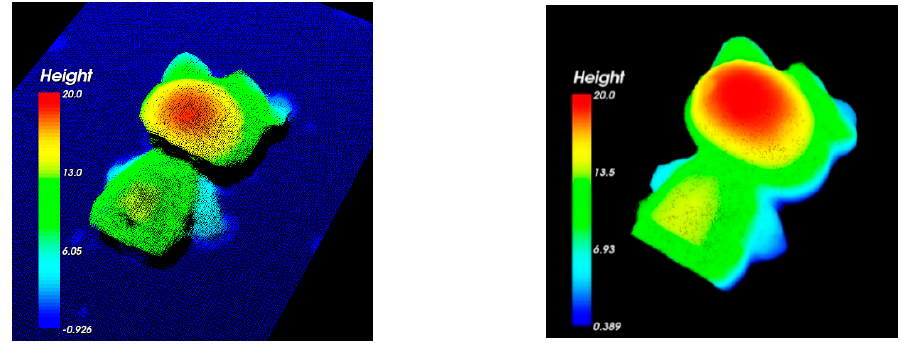
( d ) 3-D depth map obtained using traditional DIC ( e ) 3-D depth map obtained using the proposed method Figure 17. Comparison of an industrial molding part reconstructed using DIC and the proposed approach.